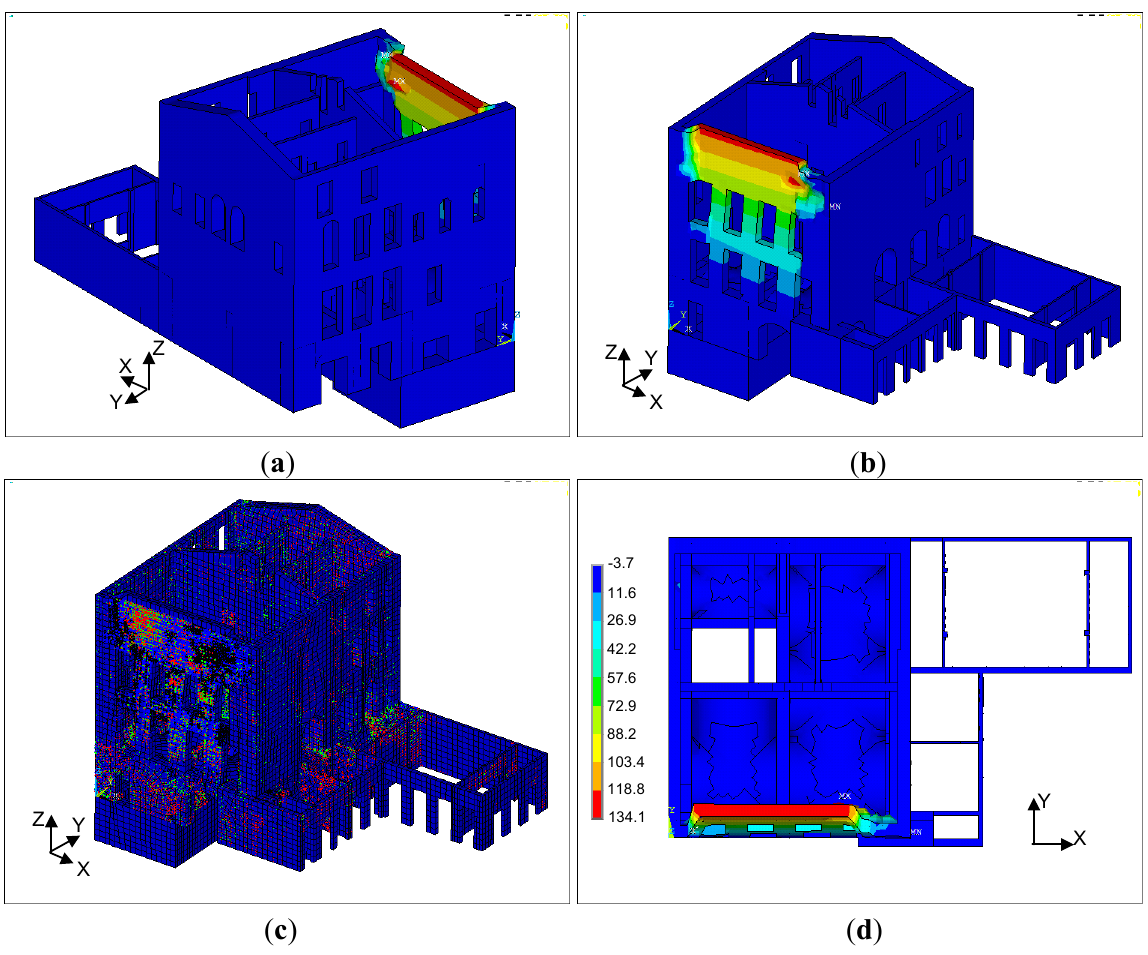
Figure 13. Pushover analysis results (+Y direction): ( a ), ( b ) and ( d ) horizontal displacement in Y direction (units are m), ( c ) final cracking and crushing patterns.